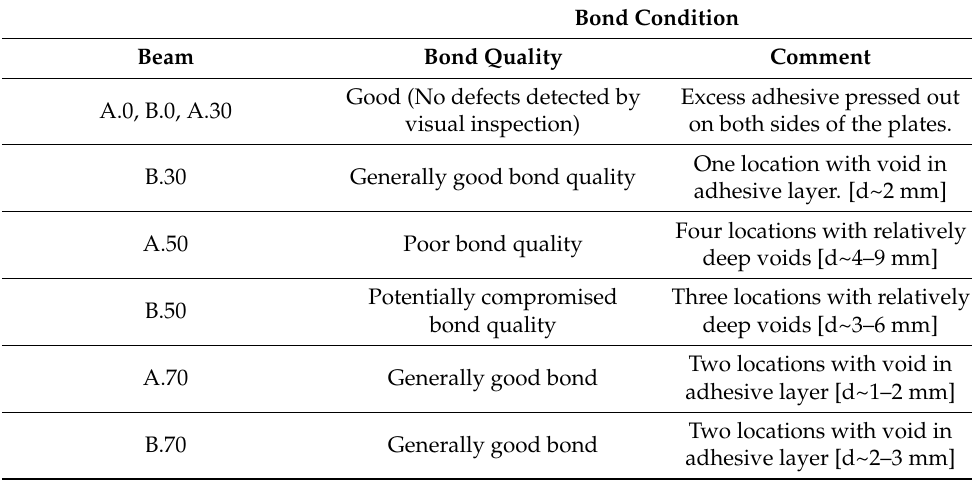
Table 4. Summary of the visual